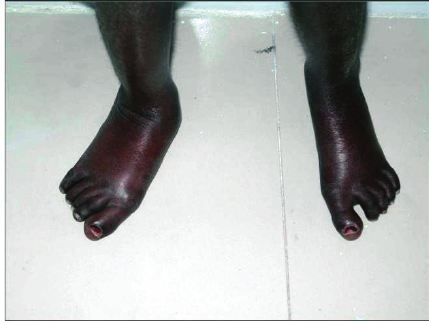
Figure 7: It shows the OPG with deformities in the mandible and partial